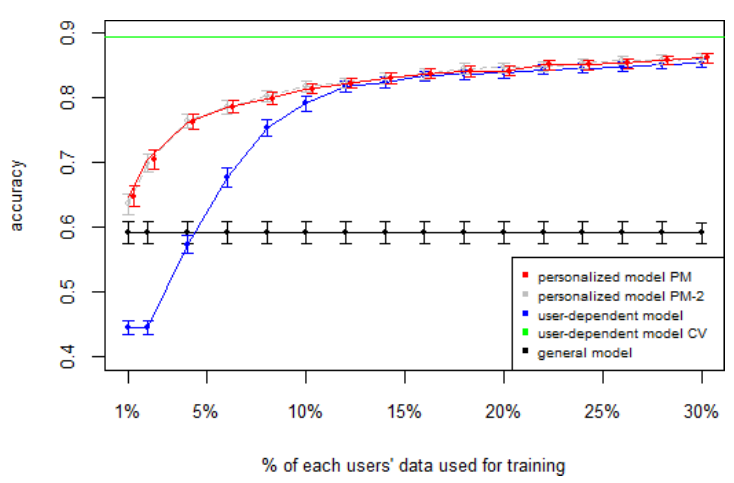
Figure 1. D1: Chest sensor dataset. PM: Personalized Model; CV: Cross Validated.